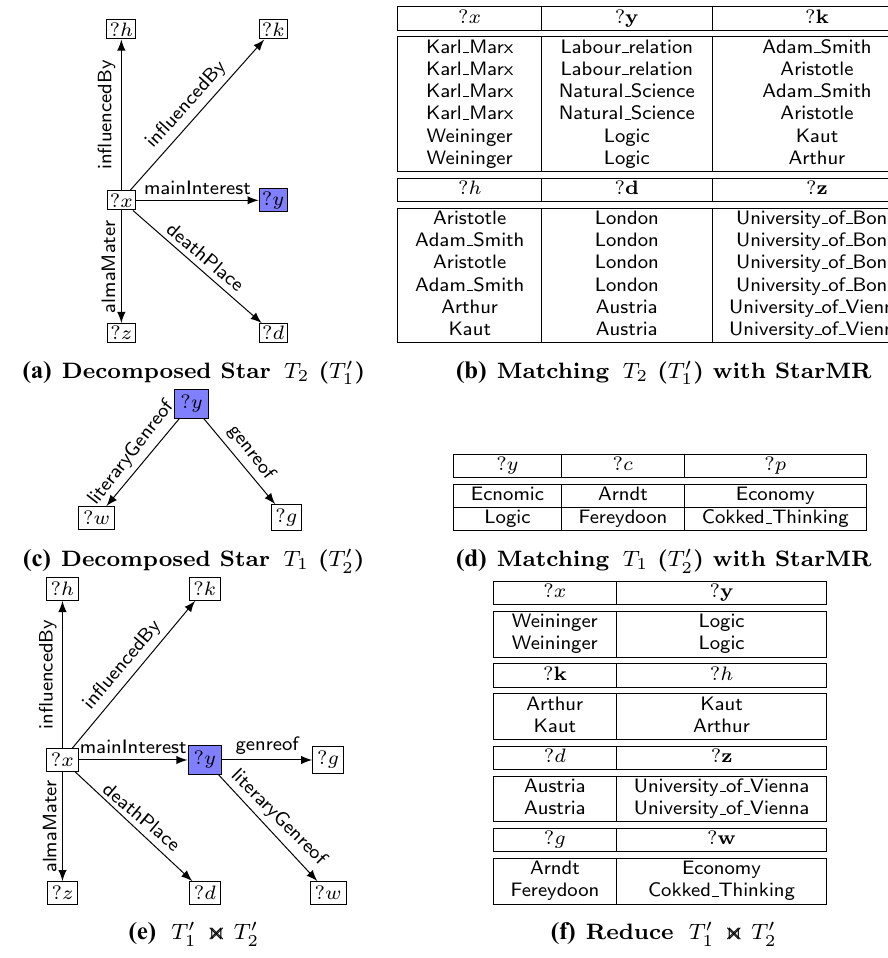
Fig. 3 Matching stars with the basic algorithm